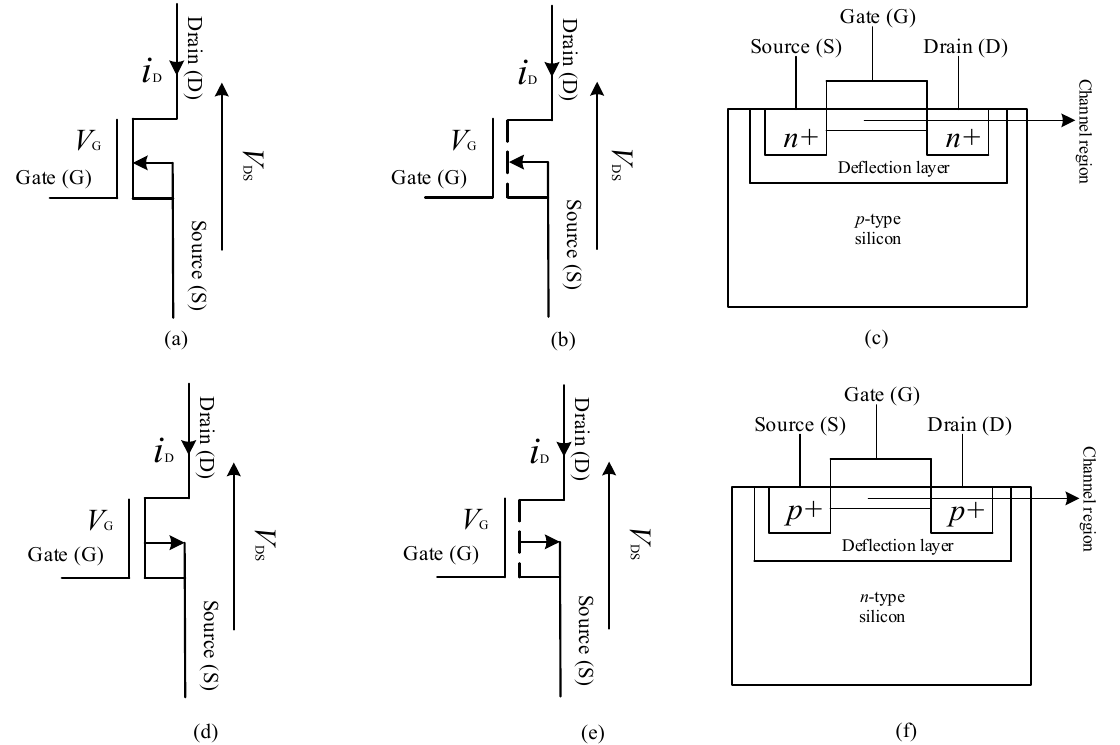
Figure 6. Diagrams showing ( a ) the schematic symbol of a depletion mode N-channel MOSFET, ( b ) the schematic symbol of an enhancement mode N-channel MOSFET ( c ) the structural diagram of an N-channel MOSFET ( d ) the schematic symbol of a depletion mode P-channel MOSFET, ( e ) the schematic symbol of an enhancement mode P-channel MOSFET and ( f ) the structural diagram of a P-channel MOSFET [110].